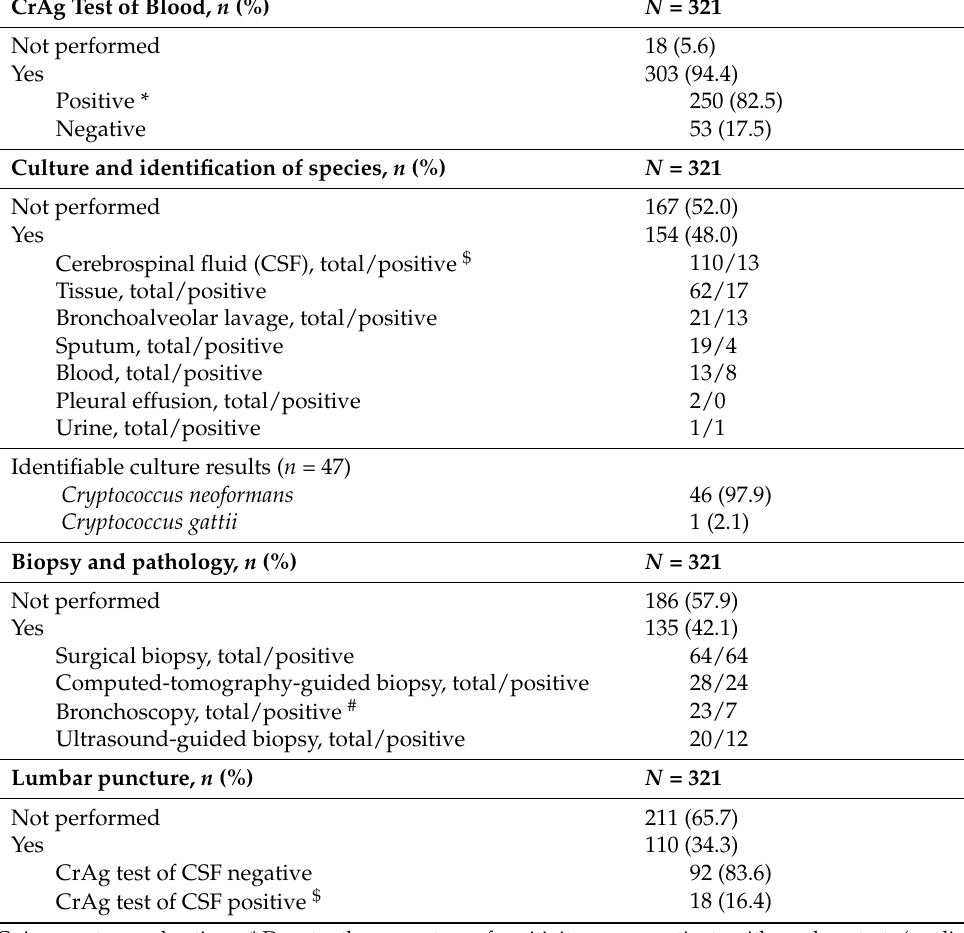
Table 3. The patterns and methods of pulmonary cryptococcosis